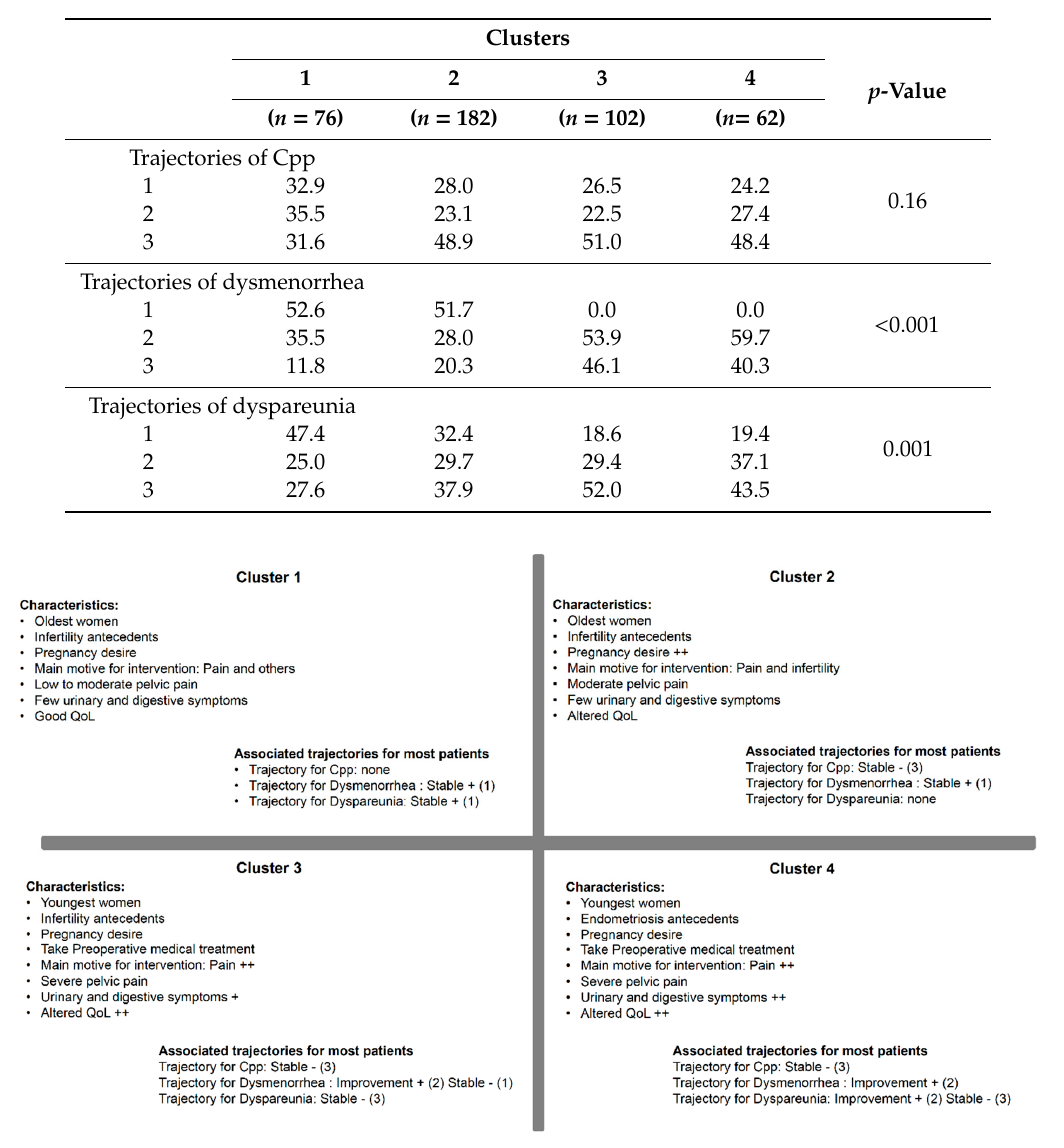
Figure 4. Characteristics of each cluster of patients. Cpp: chronic pelvic pain; QoL: quality of life. Most patients from Clusters 2, 3 and 4 (49%, 51% and 48% respectively) were in the Cpp trajectory 3 (Stable − ) though this result was not statistically significant ( p =